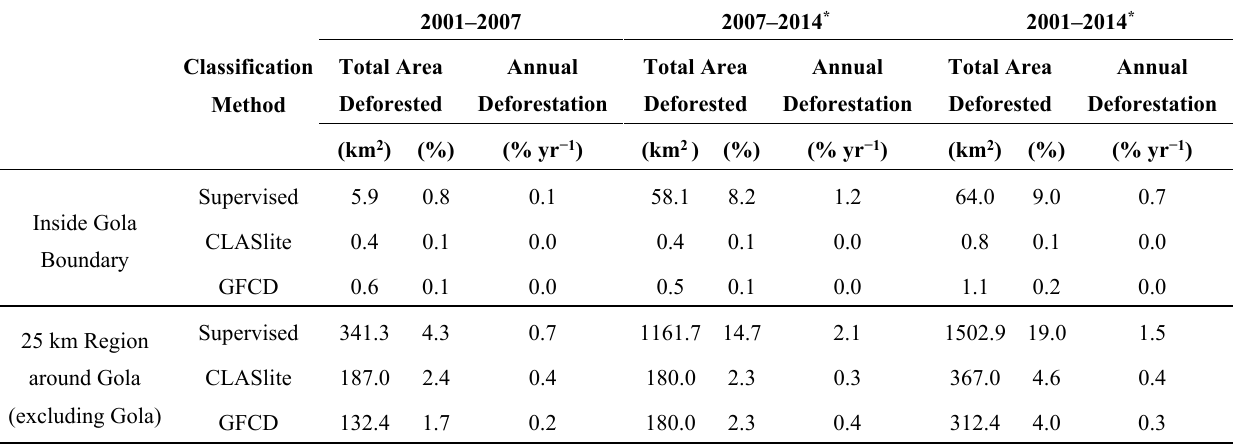
Table 3. Change statistics derived from forest cover-change maps of Gola and its surrounding 25 km region from 2001 to 2014 * resulting from three different approaches to classifying land-cover change. Total area of Gola is 710 km 2 , while the 25 km region around Gola, excluding Gola, represents an area of roughly 7900 km 2 . Values of total